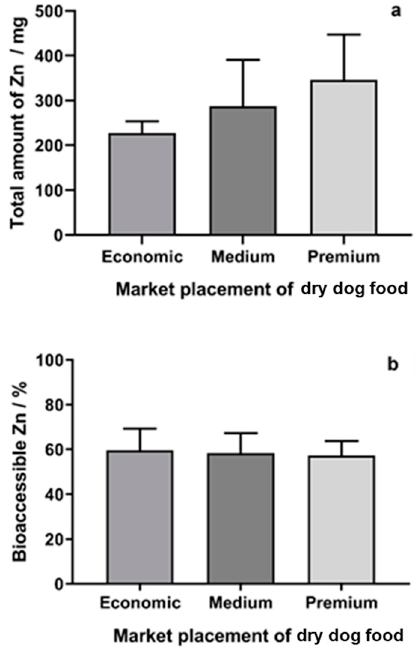
Figure 3. Total ( a ) and bioaccessible ( b ) Zn found in dry dog foods regarding their market segment.